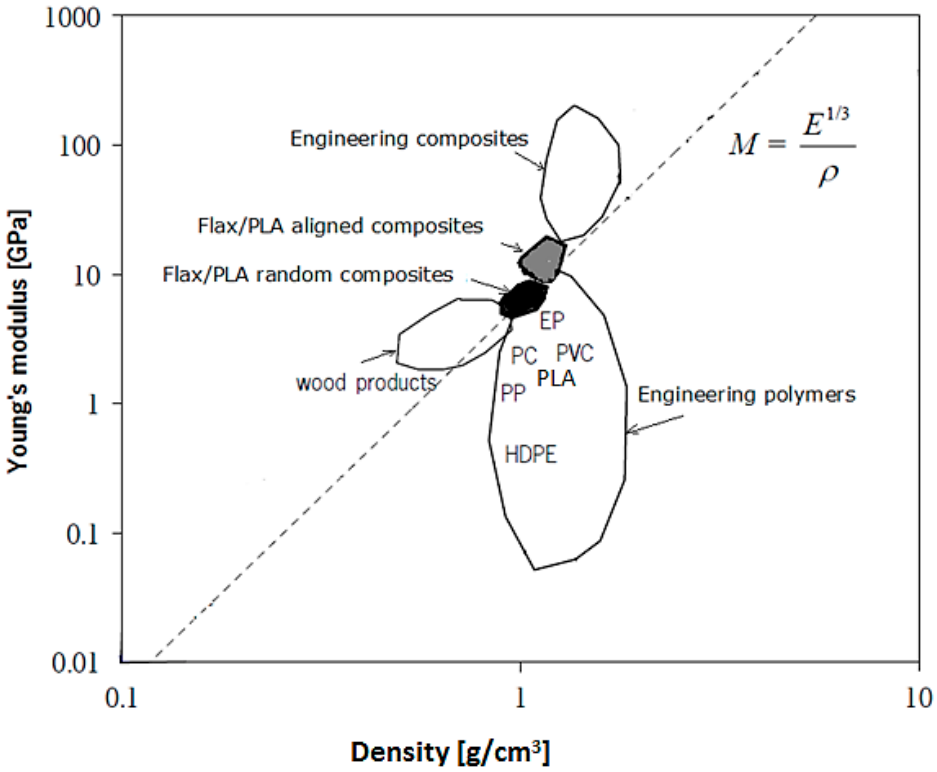
Figure 5. Materials performance chart comparing tensile modulus and density of random and aligned flax/PLA composites with common engineering polymers and composites. The dashed guide line enables materials selection for minimum mass, stiffness-limited design.